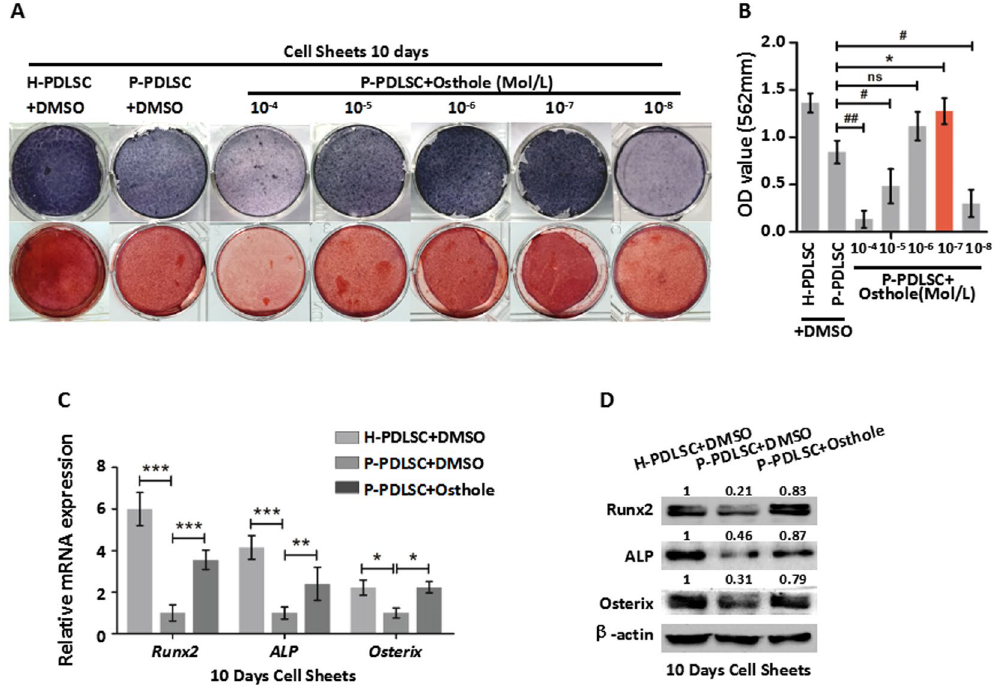
Figure 5. Osthole improves osteogenesis of P-PDLSC sheet. ( A ) ALP staining and ARS staining after 7 days (ALP staining) and 21 days (ARS staining) in H-PDLSC and P-PDLSC sheets with different concentrations of Osthole. ( B ) Quantification of ARS staining for light absorbance at 562 nm. ( C ) Gene expression of Runx2, ALP and Osterix in H-PDLSC sheet, P-PDLSC sheet and P-PDLSC sheet with 10 − 7 Mol/L Osthole. ( D ) Protein expression of Runx2, ALP and Osterix in H-PDLSC sheet, P-PDLSC sheet and P-PDLSC sheet with 10 − 7 Mol/L Osthole. * /# P < 0.05, ** /## P < 0.01, *** P < 0.001, ns: P ≧ 0.05, n =